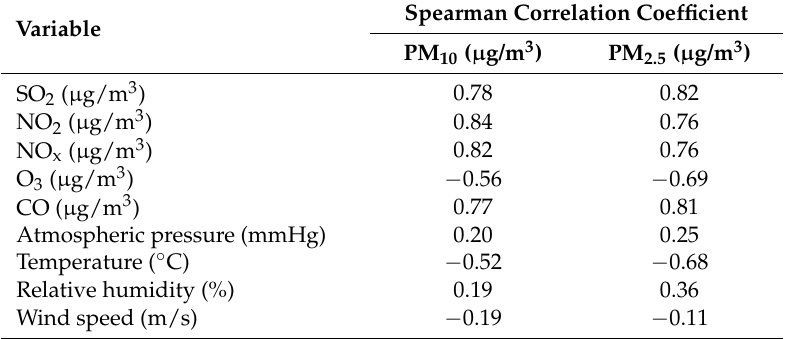
Table 2. Values of Spearman correlation coefficients in the relationships between the concentrations of fine particulate matter and other ambient air pollution and meteorological conditions (Silesia Agglomeration in the period from 1 January 2016 to 31 August